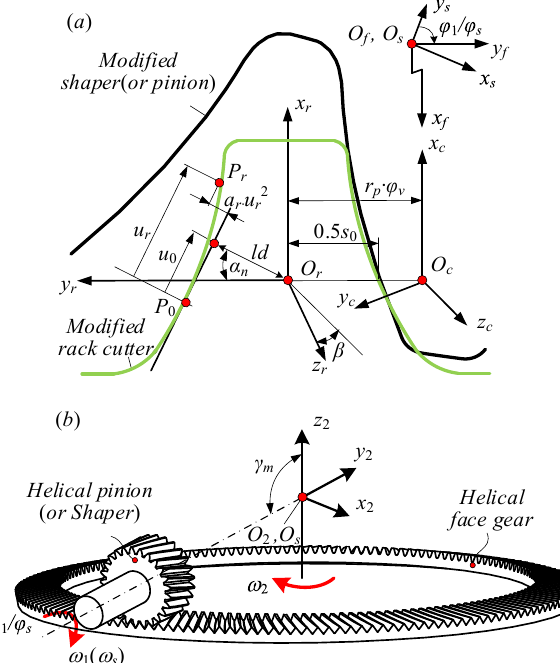
Figure 1. Generation process diagrams of modified helical face gears: ( a ) modified rack cutters envelop modified shapers; ( b ) helical gears envelop helical face gears.